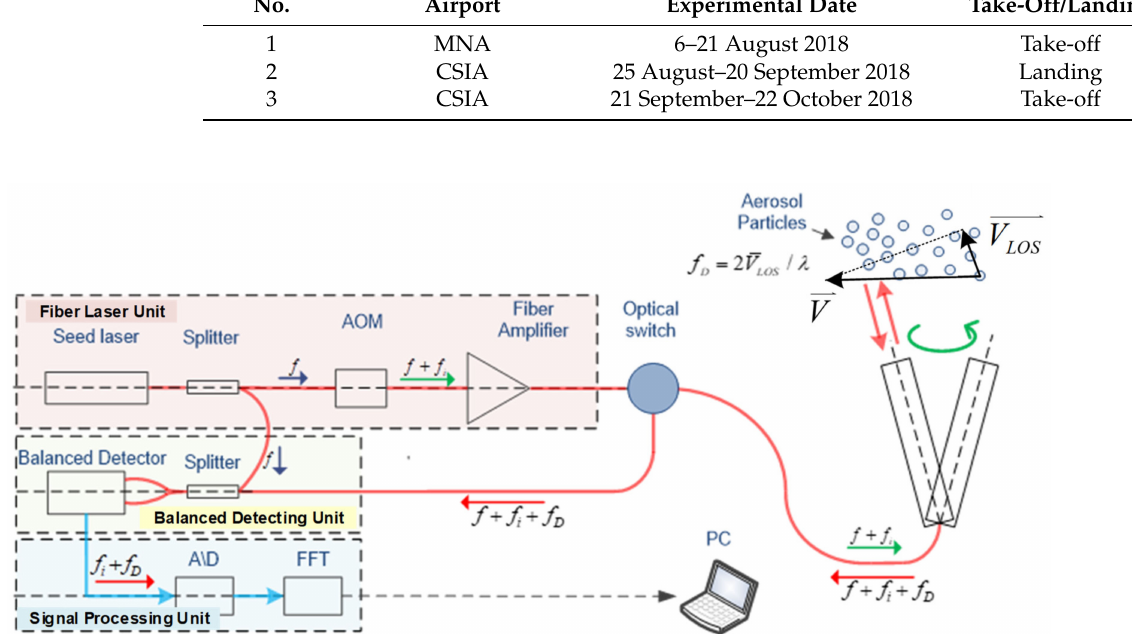
Figure 2. Schematic diagram of the pulse coherent Doppler lidar (PCDL)